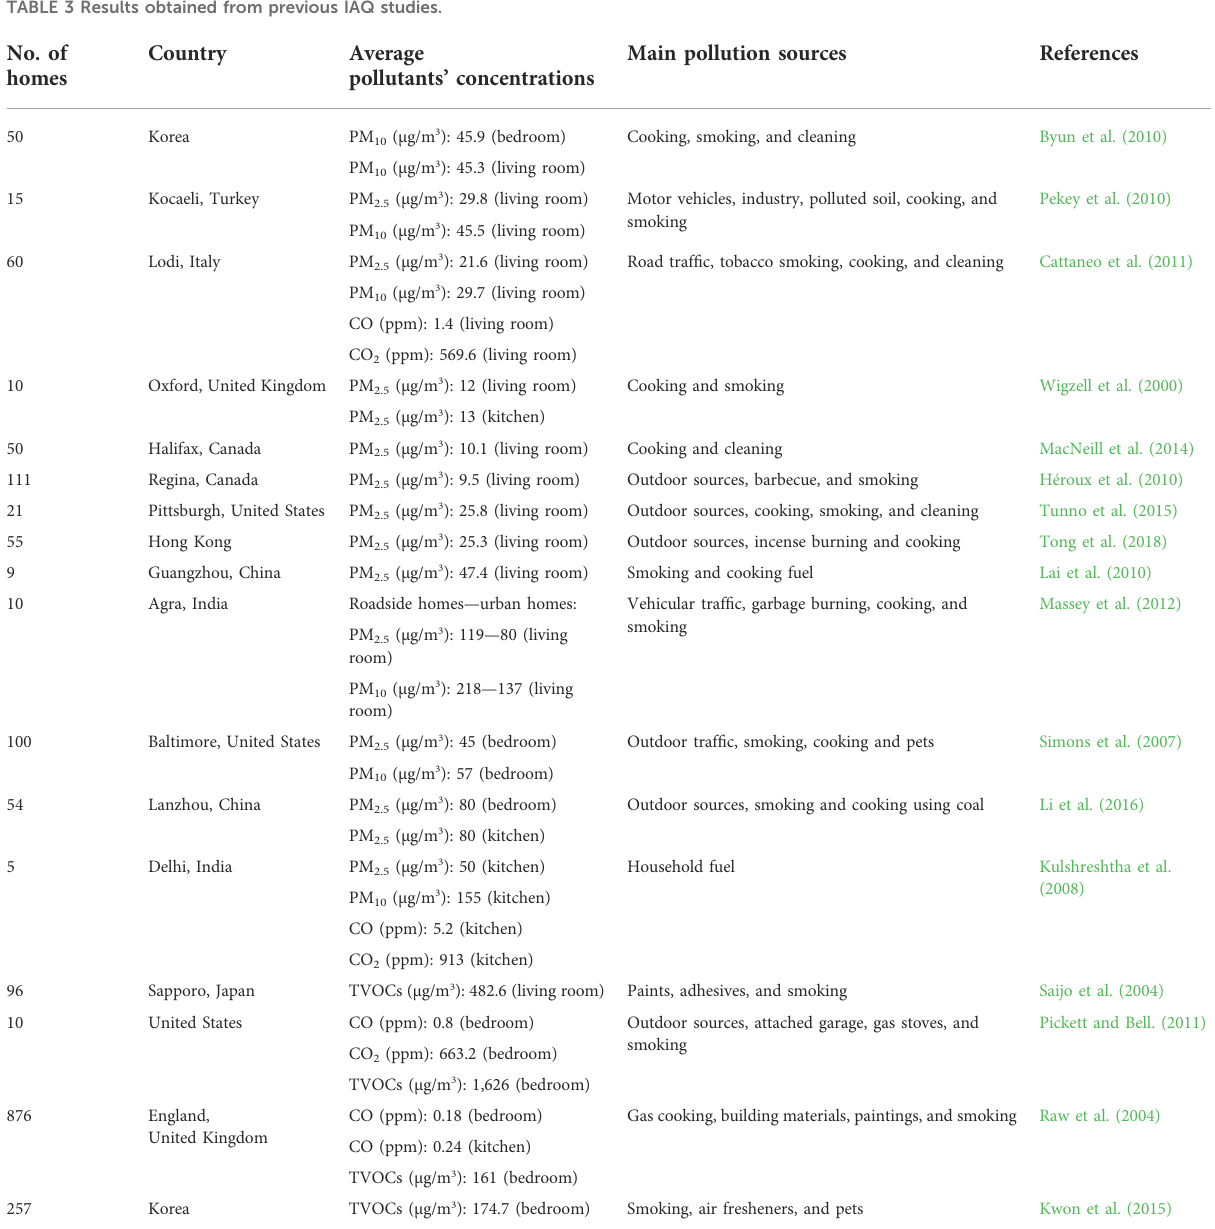
TABLE 3 Results obtained from previous IAQ